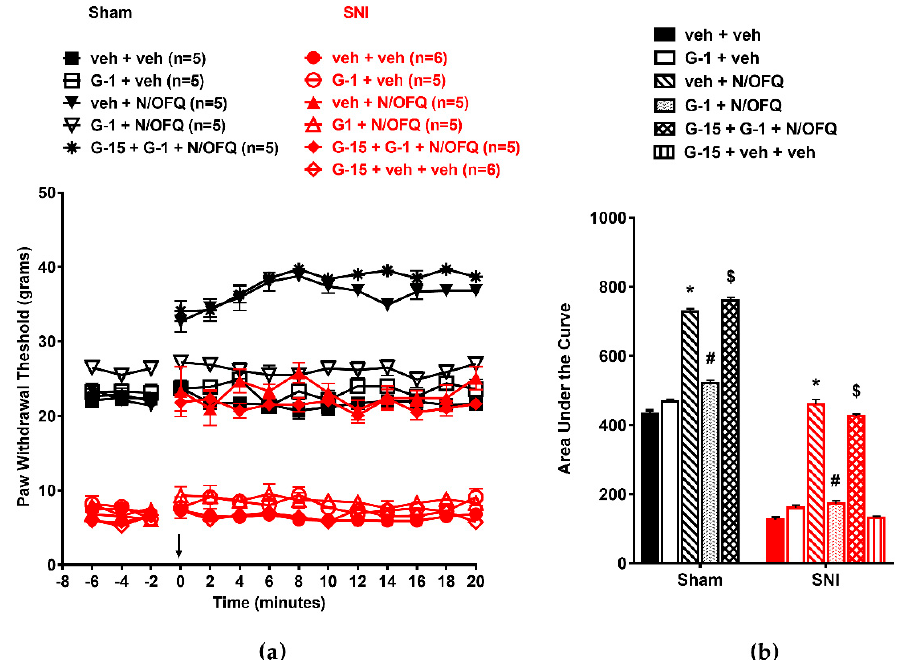
Figure 7. Selective activation of GPR30 attenuated NOP-mediated antihypersensitivity in OVX female rats: ( a ) SNI significantly reduced PWTs compared to the sham group. N/OFQ (10 nM) increased PWTs in both the sham and SNI groups. Co-administration of N/OFQ with G-1 (0.25 nM), the selective agonist for GPR30, abolished the N/OFQ-induced increase in PWTs. Pretreatment with GPR30 antagonist (G-15) restored an N/OFQ-induced increase in PWTs. ( b ) AUC analysis confirmed these effects, with a significantly reduced AUC in the SNI groups, N/OFQ significantly increasing it, and G-1 attenuating the effect of N/OFQ in an antagonist-reversible manner. Here, * p < 0.05 compared to veh + veh; #, p < 0.05 compared to veh + N/OFQ; $, p < 0.05 compared to G-1 + N/OFQ. In male animals, intrathecally administered N/OFQ reversed SNI-induced tactile hypersensitivity ( F (130,637) = 7.10; p < 0.05), and G-1 co-administration blocked this effect ( p < 0.05; Figure 8a). The AUCs were similarly affected ( F (10,59) = 99.82; p < 0.05; Figure 8b).